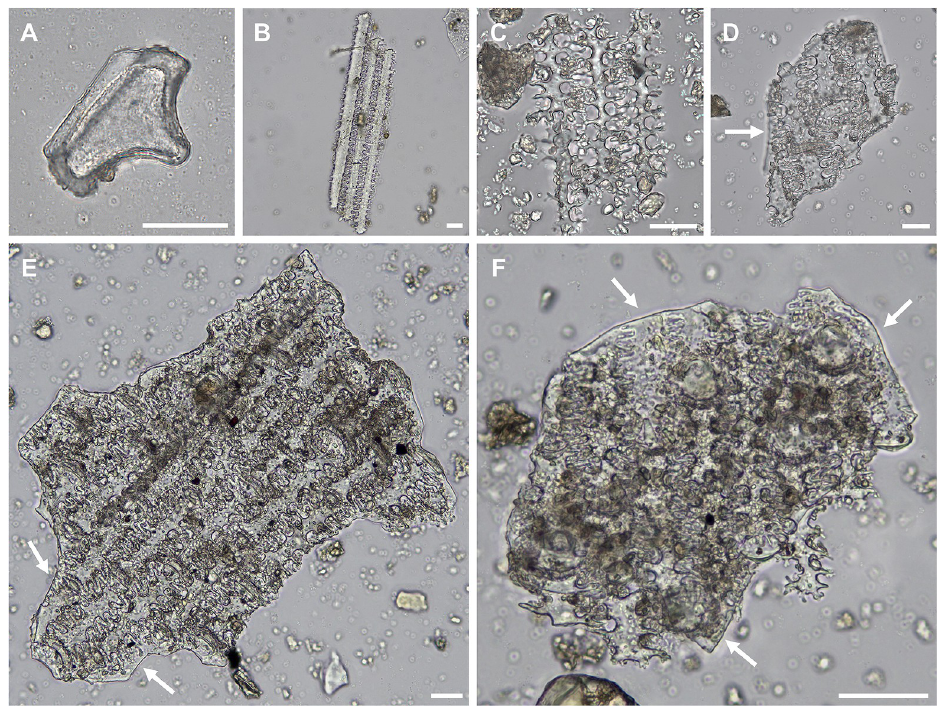
Fig 11. Examples of phytolith morphotypes extracted from sediment samples from KDK1 Middle Neolithic grave fills. (A) B ULLIFORM FLABELLATE phytolith extracted from sediment adhering to individual SK 42; (B–F) Phytoliths extracted from sediment adhering to individual SK 55, (B) Articulated E LONGATE DENTATE phytoliths; (C) Articulated E LONGATE DENDRITIC phytoliths; (D) Articulated E LONGATE DENDRITIC with attached I NTERDIGITATE layer; (E–F) Articulated E LONGATE DENDRITIC with attached I NTERDIGITATE layer and P APILLATE cells. White arrows in Panel D, E and F indicate I NTERDIGITATE phytolith layer attached to E LONGATE DENDRITIC phytoliths. Scale bar (20 μ m) applies to all panels.